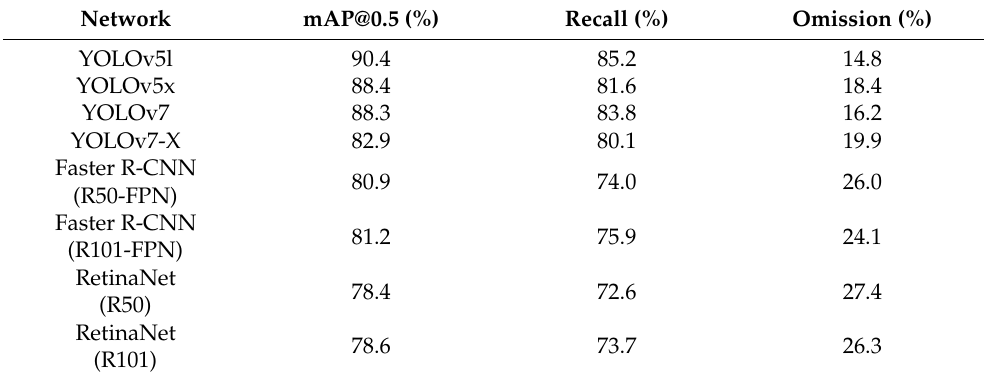
Table 3. The training results based on dataset-1 (randomly divided in the ratio of 6 to 2 to 2).